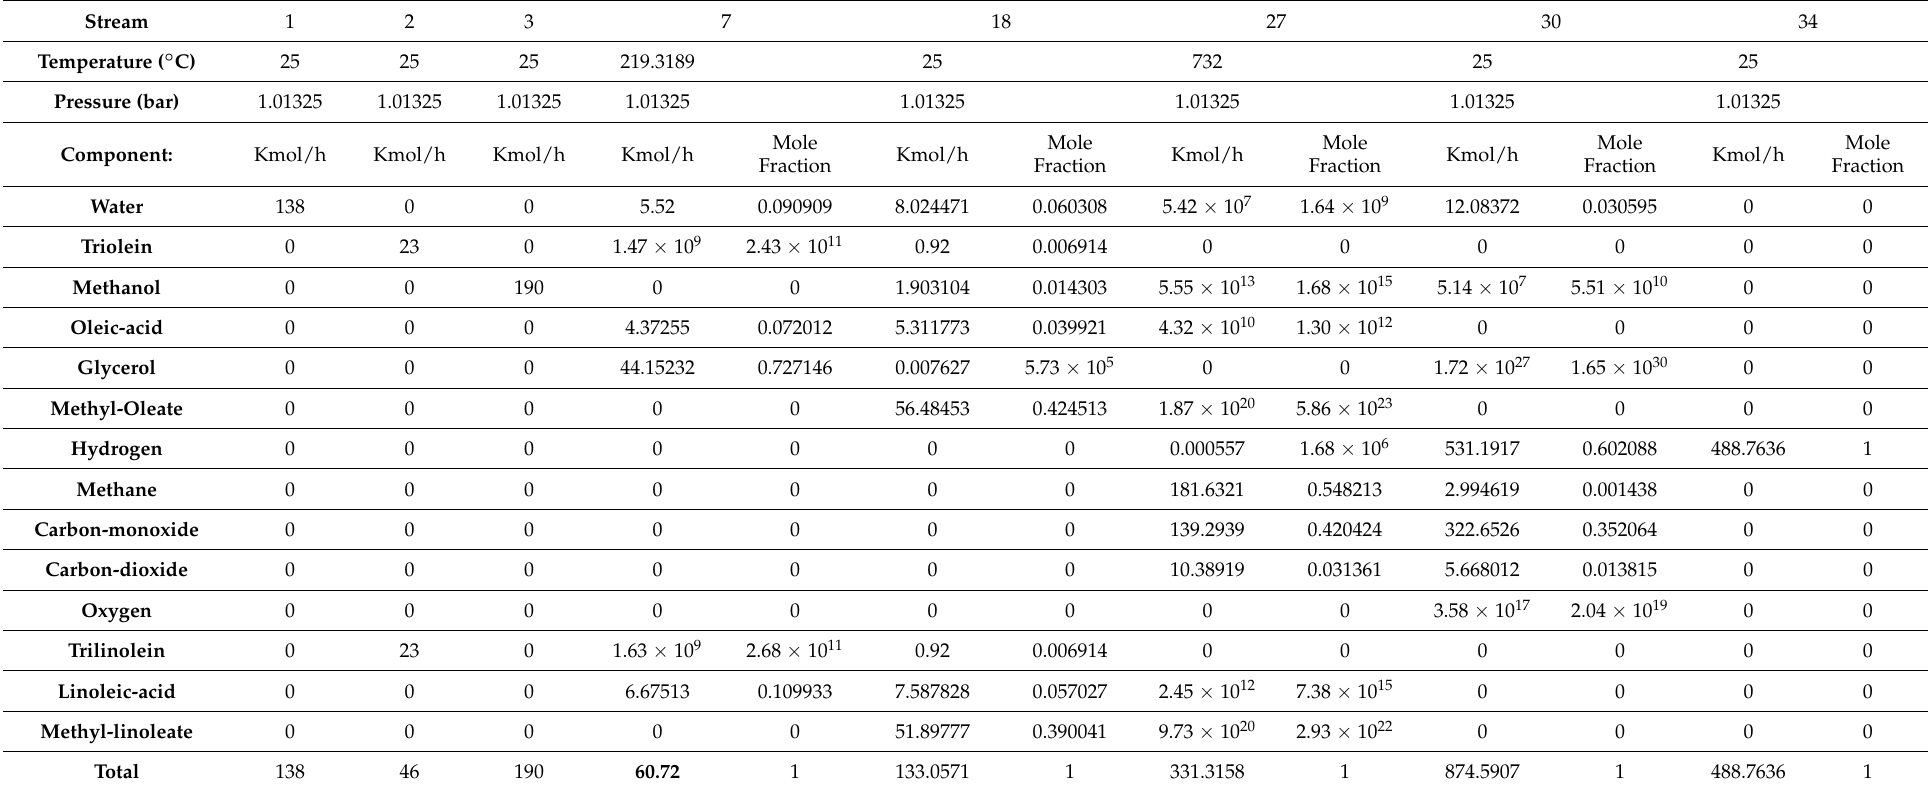
Table 2. Key Stream Results for the Integrated